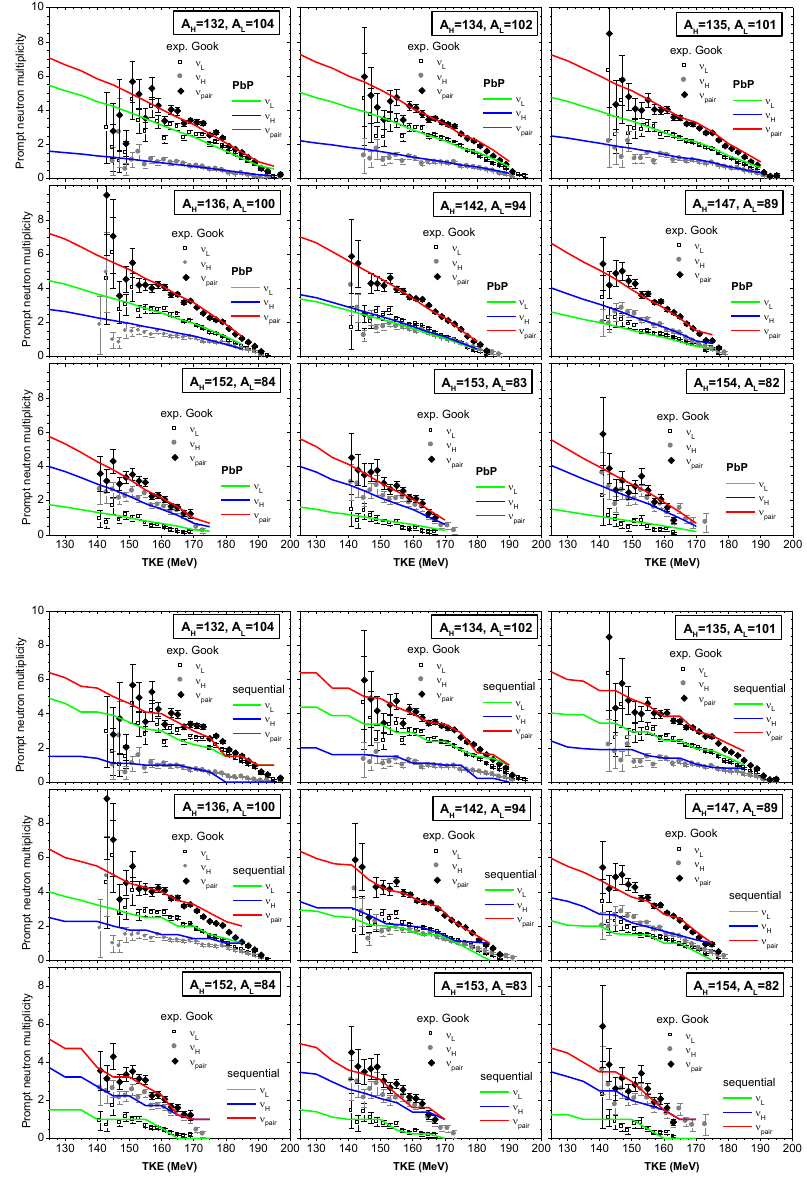
Fig.1 . Comparison of the ν (A,TKE) results of PbP (upper part) and sequential emission (lower part) with the recent data of Göök et al. in the representation as ν (TKE) for a given fragment